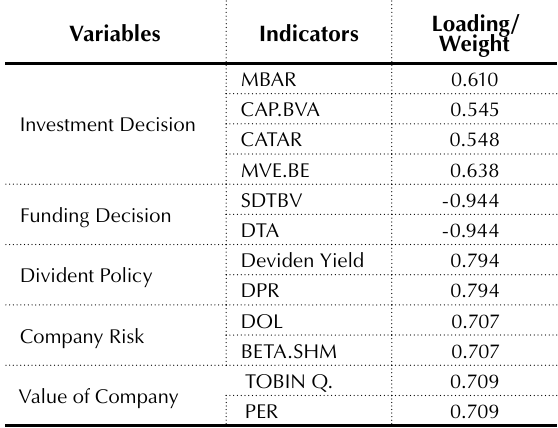
Table 1. Measurement model